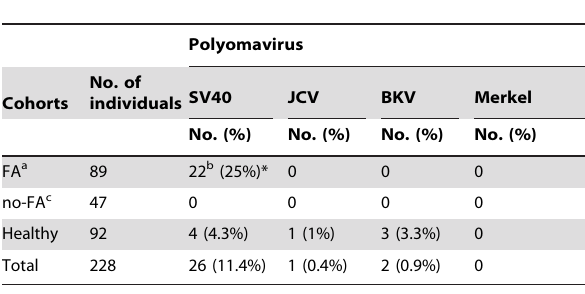
a FA: Fanconi anemia patients. b The DNA used for the analysis derived from different biological sources. The SV40 sequences were detected in DNA from 14 out of 54 (26%) peripheral blood cell samples, 8 out of 32 (16%) from lymphoblast cell lines and in none of